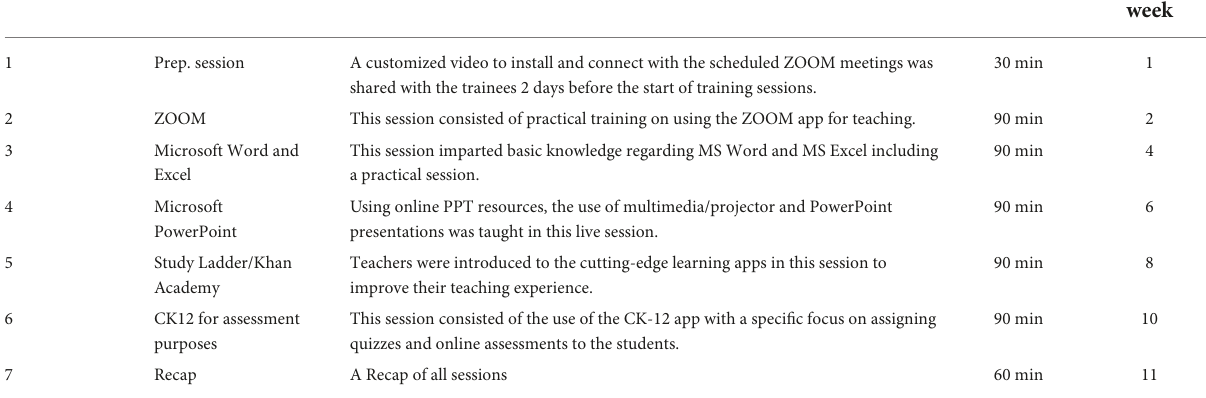
TABLE 2 Details of training